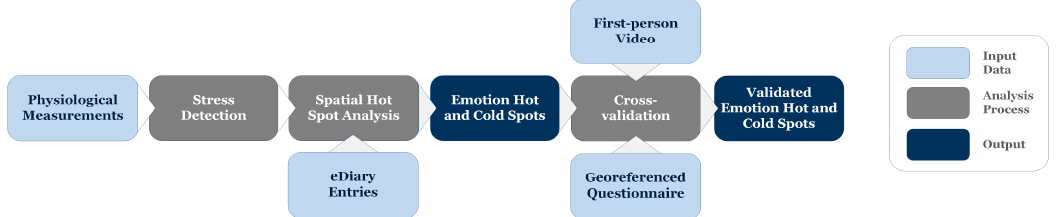
Figure 1. Workflow of the presented mixed-methods approach.